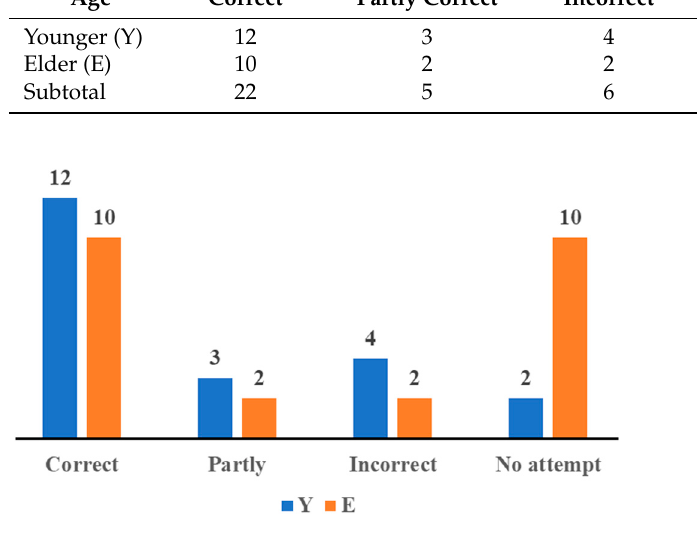
Figure 7. Frequency distribution of student’s results and no attempts by age groups. Table 9. Frequencies of student’s results and no attempts by age groups.